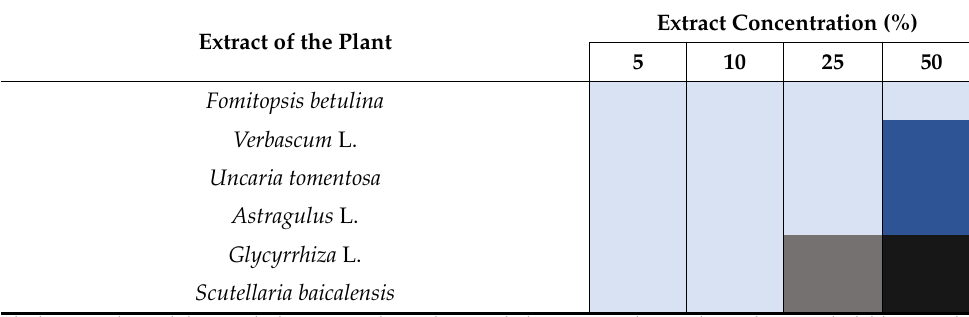
Table 5. The influence of plant extracts on P . syringae growth. Extract of the Plant Fomitopsis betulina Verbascum L. Uncaria tomentosa Astragulus